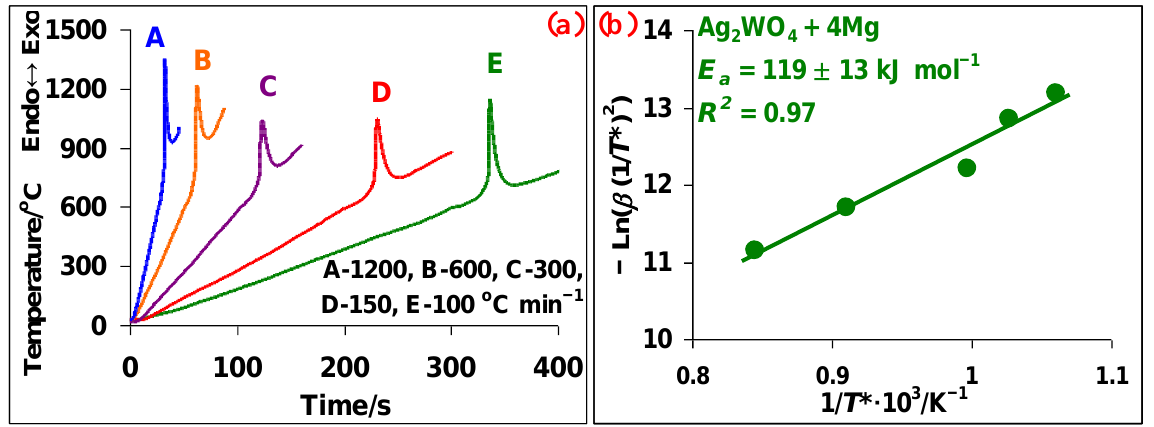
Figure 4. Heating curves of the Ag 2 WO 4 + 4Mg mixture at various heating rates, β = 100 – 1200 °C min −1 ( a ) and effective activation energy plot for the Ag 2 WO 4 + 4Mg interaction ( b ).